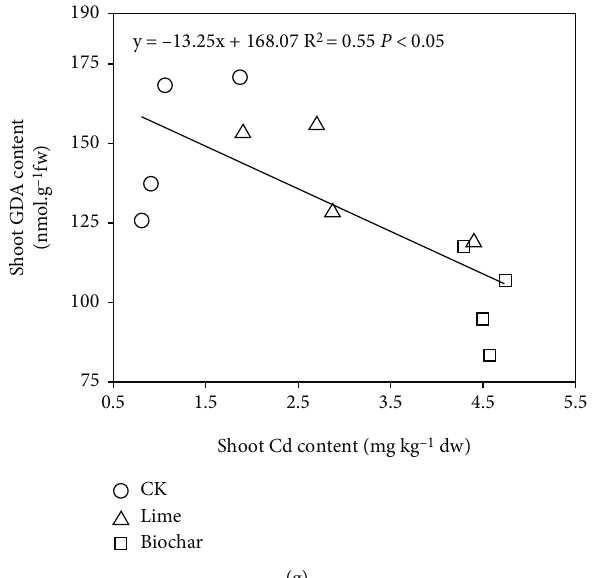
Figure 3: Relationships between Cd accumulation and related physiological traits. MDA: malondialdehyde; H superoxide anion; and GDH: glutamate